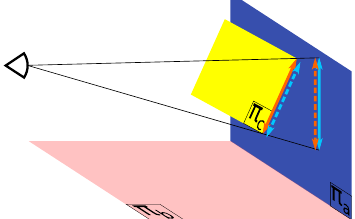
Figure 8. Detection of occlusion straight line segments from contour lines of interaction between planes. The solid lines represent the segments detected by RANSAC 2D on the planes and the dashed lines represent their projections on the other